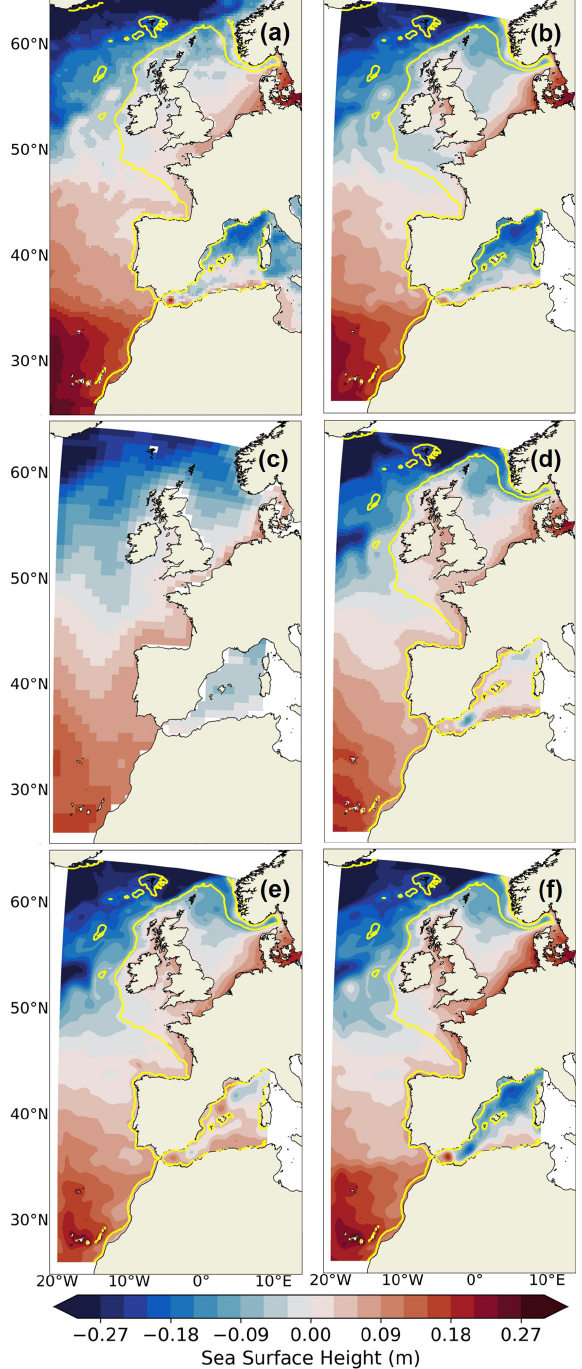
Figure 6. Mean sea surface height over the 1993–2014 period in (a) MDT CNES-CLS-18, (b) IBI-ERAi, (c) CNRM-CM6-1, (d) CNRM-CM6-1-HR, (e) IBI-CCS_raw and (f) IBI-CCS_corr. Note that all panels here do not include the inverse barometer ef- fect on sea level. The shelf break (defined by the 200m isobath) is indicated in